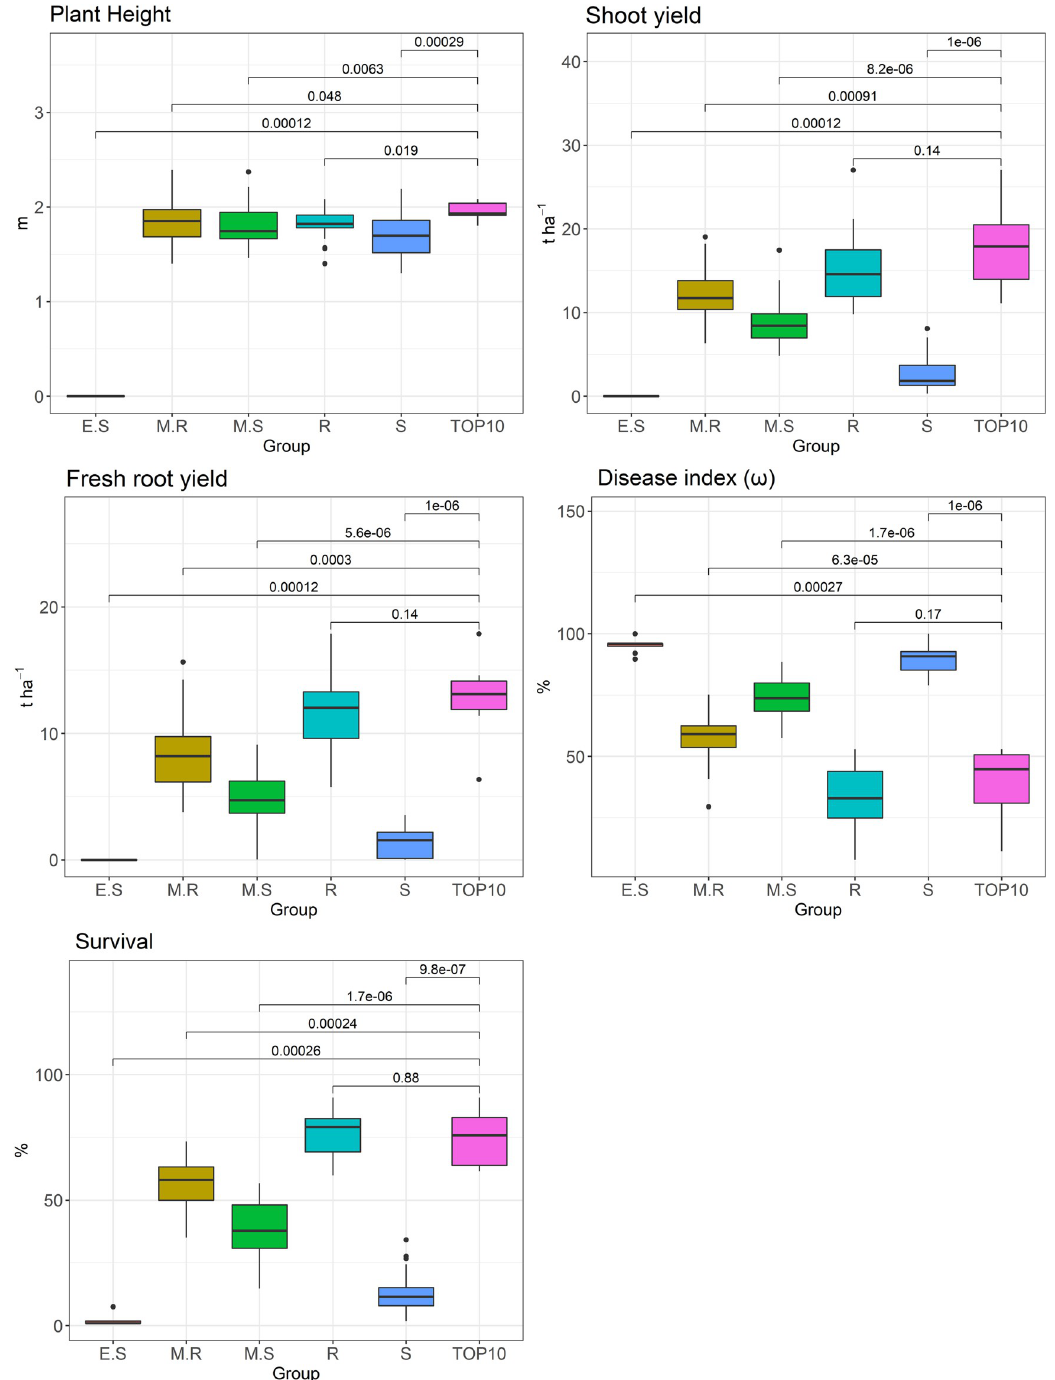
Fig 4. Boxplot of the clusters formed based on plant height, shoot and fresh root yields, survival, and disease index ( ω ) evaluated for 148 cassava genotypes planted in a field naturally infested with root rot pathogens. ES: extremely susceptible; S: susceptible; MS: moderately susceptible; MR: moderately resistant; R: resistant.